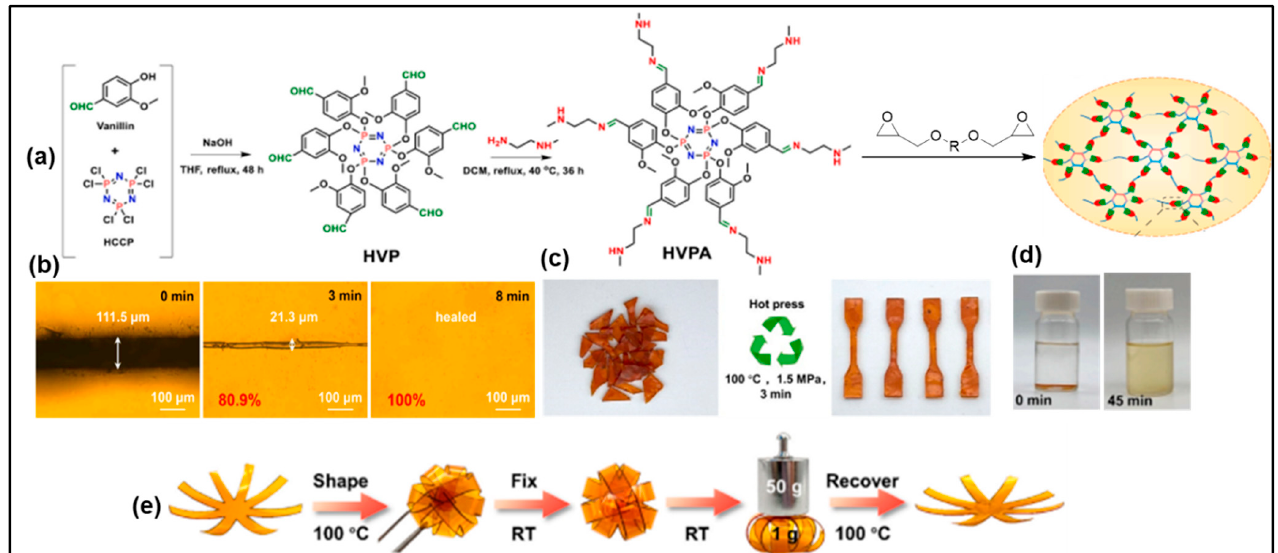
Figure 16. ( a ) Synthesized way of imine bond containing hardener (HVPA) from vanillin and its cured network; repairability ( b ), reprocessability ( c ), degradability ( d ), and reformability ( e ) of the cured thermoset [reproduced with permission from Peng et al.; published by Elsevier, 2022] [79].